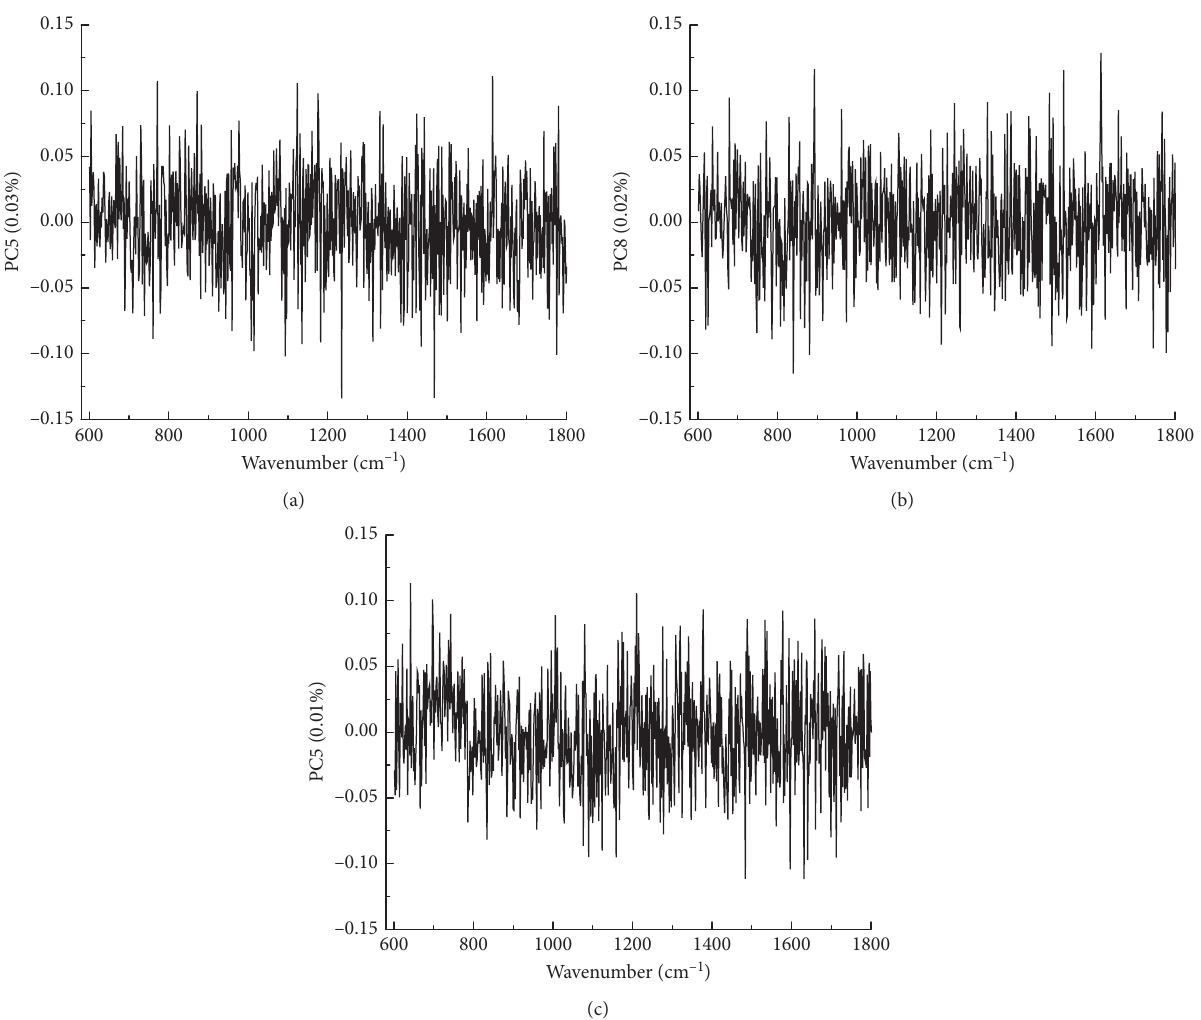
Figure 6: Principal component loadings that explain natural grouping of PNT1a and PC3 scores due to (a) PC5 (0.03%) for stage 1, (b) PC8 (0.02%) for stage 2, and (c) PC5 (0.01%) for stage 3 datasets. The loadings profiles are noted to contain useful peaks amid noisy features. The useful peaks (weak Raman bands) were extracted from the raw loading profiles by adjustment of threshold and sensitivity levels/parameters in peak finding function in Omnic ® software from Thermo Scientific. Sensitivity levels were set at a low value (30%) so that noise and other unimportant features above threshold value were